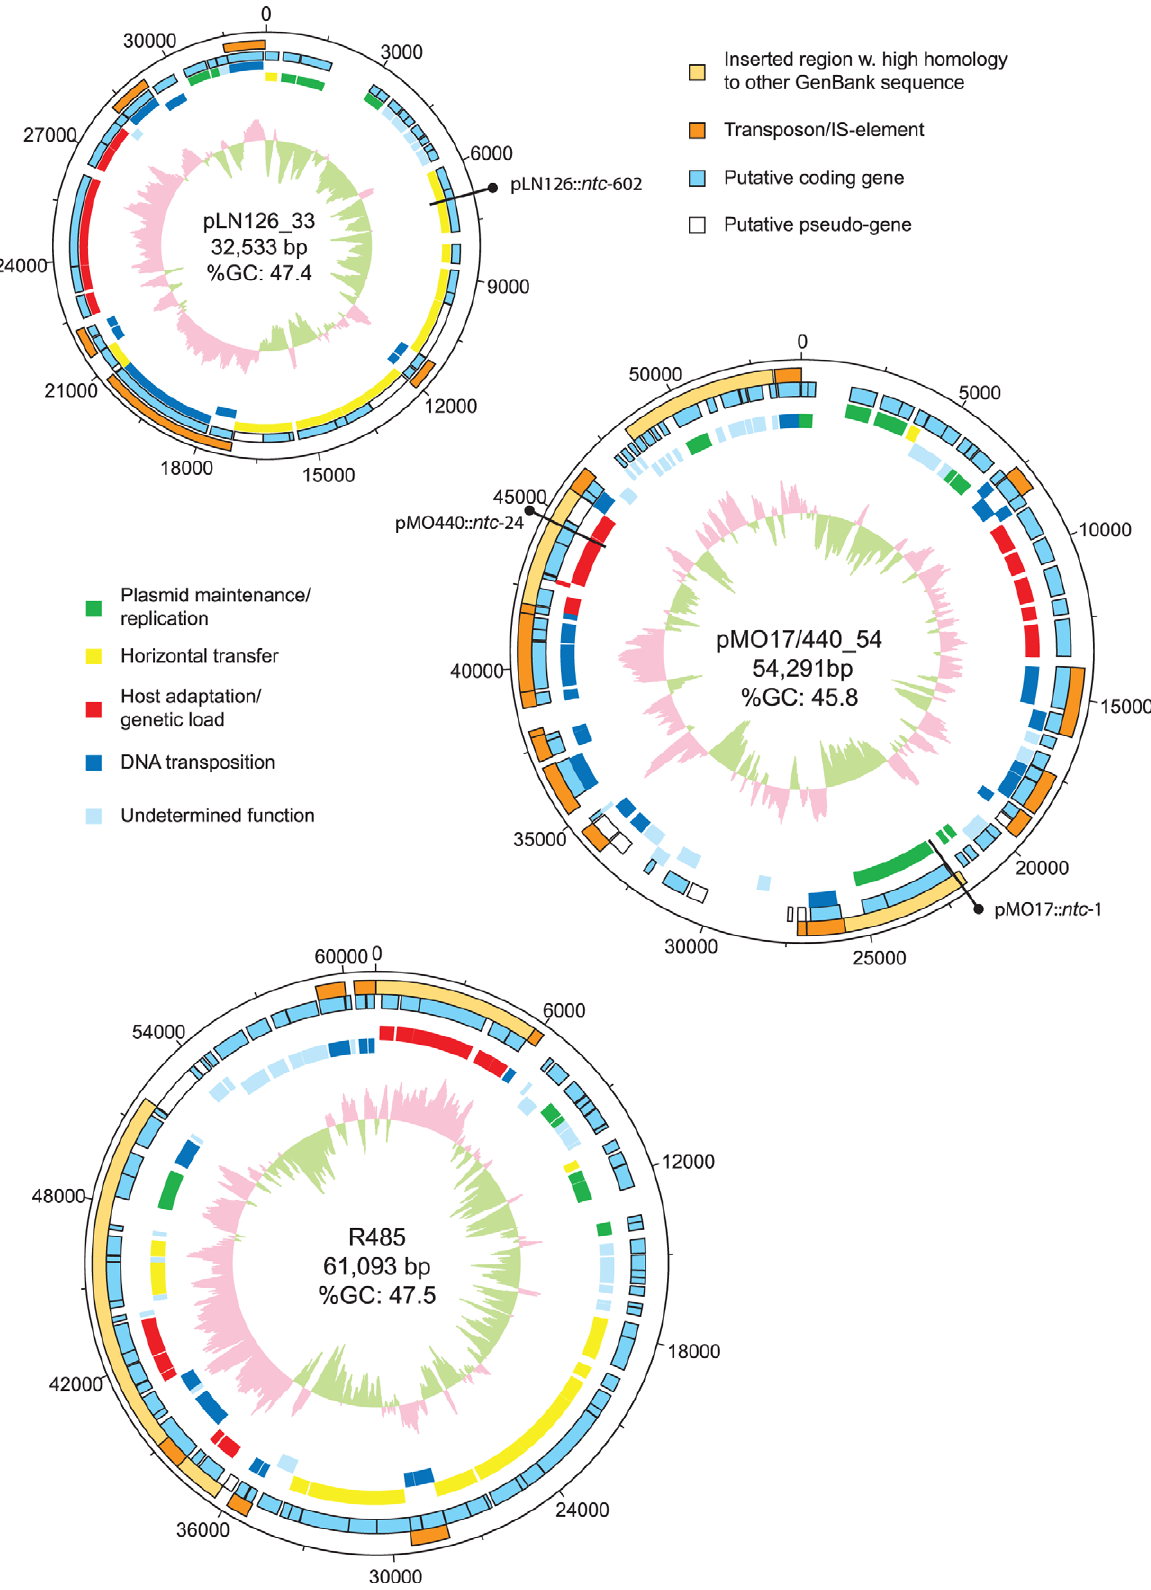
Figure 2. Sequence Maps. Graphical representation of the annotated IncX-type plasmids, pLN126_33, pMO17/440_54 and R485. The central diagrams represent the %GC content. Black pins represent the insertion points of the Entranceposon derivatives.